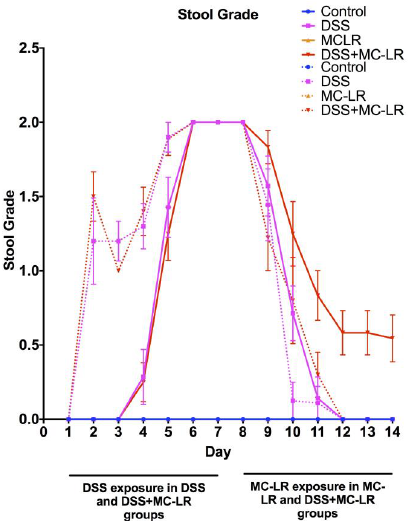
Figure 2. Daily stool grading throughout the 14-day study; 0 = no occult or gross blood, 1 = occult blood present, and 2 = gross blood present. Data presented indicate the mean ± SEM ( n = 6–11 mice per group). Solid lines indicate WT mice. Dotted lines indicate CD40KO mice.